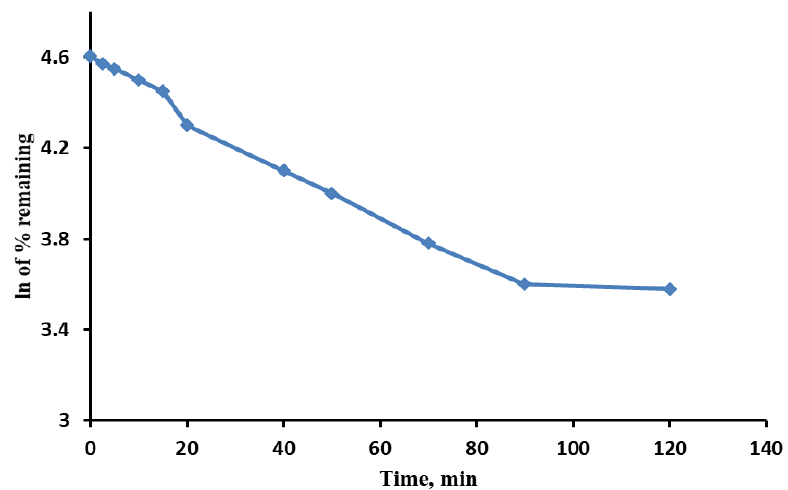
Figure 3. The metabolic stability profile of VNB in HLMs.